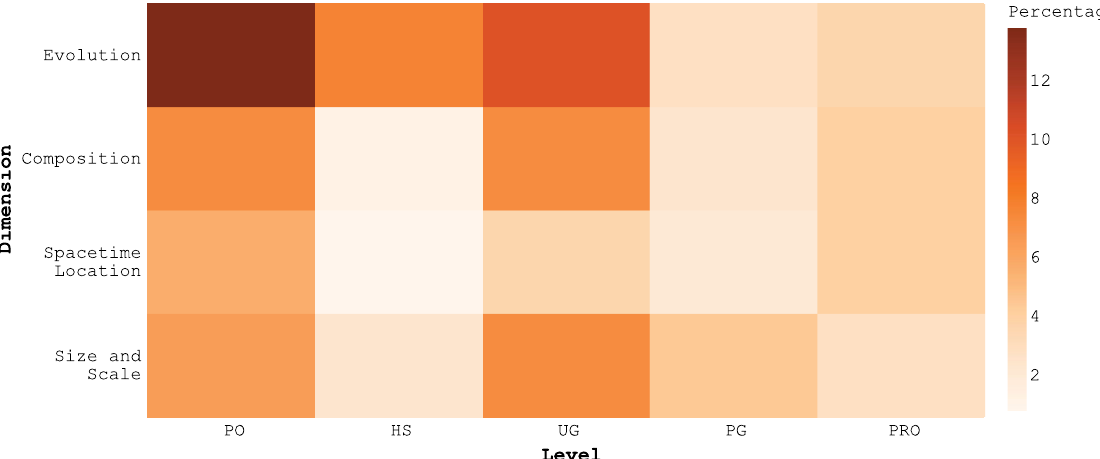
FIG. 9. A visualization showing distribution of the representations for each target audience level (Public outreach, high school, undergraduate, postgraduate, and professional) across the four dimensions, as a percentage of the total number of representations n ¼ 247 . The darker shades represent higher percentages.